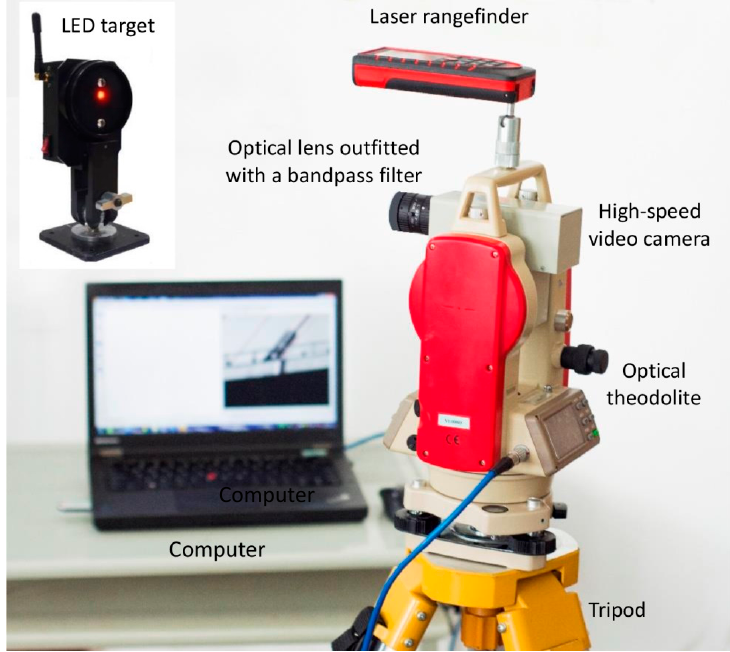
Figure 1. The established video deflectometer for bridge deflection measurement.